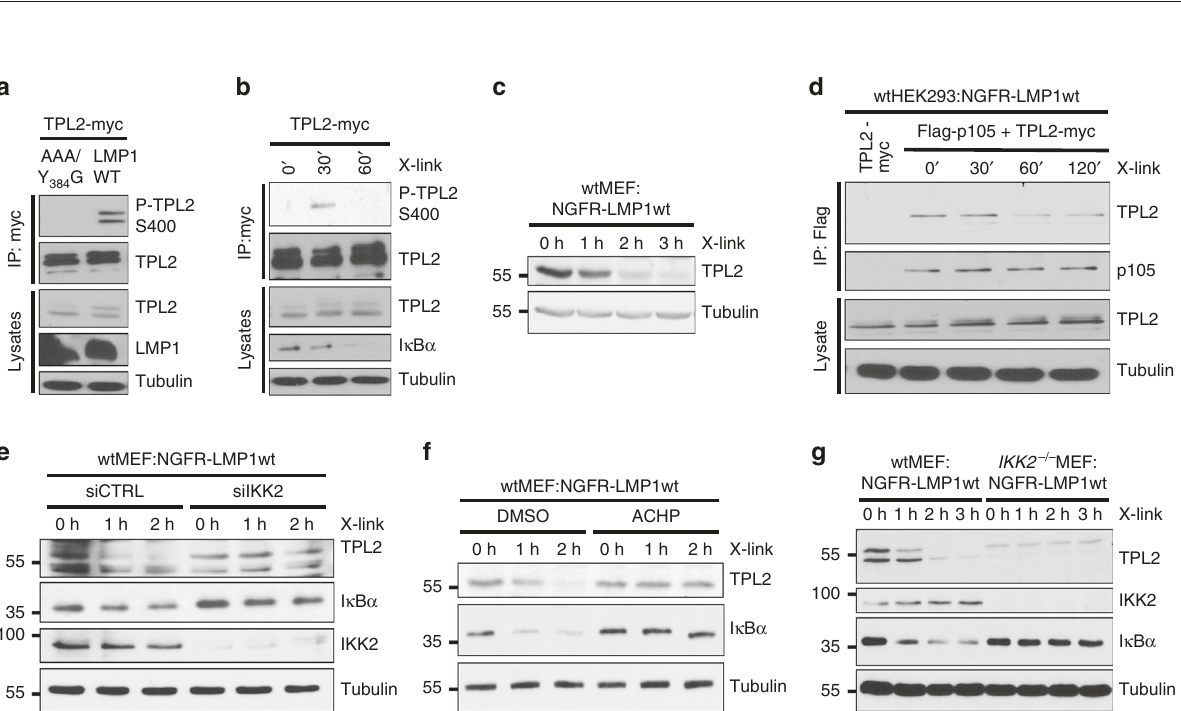
Fig. 3 The role of TAK1 in JNK and NF- κ B signaling by LMP1. a Pharmacological TAK1 inhibition blocks JNK, but not canonical NF- κ B activation by LMP1. NGFR-LMP1 was induced by antibody crosslinking in the presence of DMSO or 500 nM of the TAK1 inhibitor (5Z) − 7-oxozeaenol (TAK1-IH). b LMP1- induced IKK2 activity depends on the presence of TAK1 protein, but TAK1 kinase activity is dispensable. TAK1-de fi cient HEK293 cells (clone 3) or corresponding wildtype cells were transfected with Flag-IKK2 together with HA-LMP1, the inactive mutant HA-LMP1(AAA/Y384G), or empty vector. Where indicated, the cells were treated with 500 nM TAK1-IH for 5 h prior to cell lysis. Flag-IKK2 kinase assays were performed. IKK2 activity was measured as radioactive GST-I κ B α phosphorylation (topmost panel). Phosphorylation of immunoprecipitated Flag-IKK2 at serines 177/181 was detected on immunoblots. c JNK activation by LMP1 requires both TAK1 protein and its kinase activity. Experiments were essentially performed as described under c , except that HA-JNK1 was transfected and assayed using GST-c-Jun as substrate. For kinase assay quanti fi cation and statistics see Supplementary Table 4. d IKK2 activation involves IKK2 autophosphorylation. HEK293 cells were transfected as indicated and treated with DMSO, IKK inhibitor ACHP or TAK1-IH. Phosphorylation of imunoprecipitated Flag-IKK2 at serines 177/181 was detected. e LMP1 depends on TAK1 protein, but not its kinase activity, to induce K63-ubiquitination of NEMO. HEK293 and TAK1 crKO HEK293 cells were transfected with HA-Ubiquitin K63 and Flag-NEMO together with LMP1 wildtype or empty vector (w/o). After 24 h, cells were treated with 500 nM TAK1-IH where indicated. Flag-NEMO was immunoprecipitated (IP) using the Flag (6F7) antibody. K63-linked ubiquitination of NEMO was detected by the HA (3F10) antibody. f TAK1 mediates IKK2 interaction with the LMP1 complex. HEK293 wildtype and TAK1 crKO cells were transfected with Flag-IKK2 together with HA-LMP1 wildtype or AAA/ Δ 371 – 386 lacking CTAR2. Flag- IKK2 was precipitated via the Flag (6F7) antibody and interacting LMP1 was detected by the HA (3F10) antibody. CRISPR/Cas9 knockouts were veri fi ed by immunoblotting (This Figure) and by sequencing (see Supplementary Table 2). a – f The data are representative of at least two independent experiments. a – b , d – f For immunoblot quanti fi cation and statistics see Supplementary Table 3.